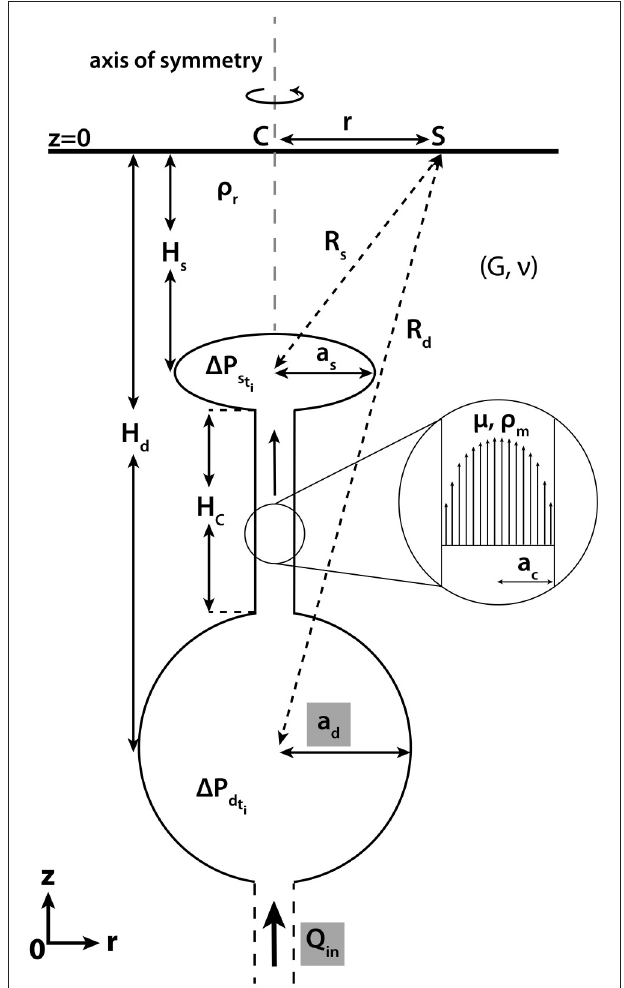
FIGURE 1 | Schematic sketch of the two chamber model, modified after Reverso et al. (2014). The magma inflow rate at the bottom chamber Q in and the radius of the deep reservoir a d are the two parameters considered to be uncertain in this study. Observations (vertical and horizontal displacements) are recorded at the surface at a given location S characterized by its distance r from the center of the volcanic system C . R s r 2 H d 2 are distances between S and the shallow and deep R d + = reservoirs, q